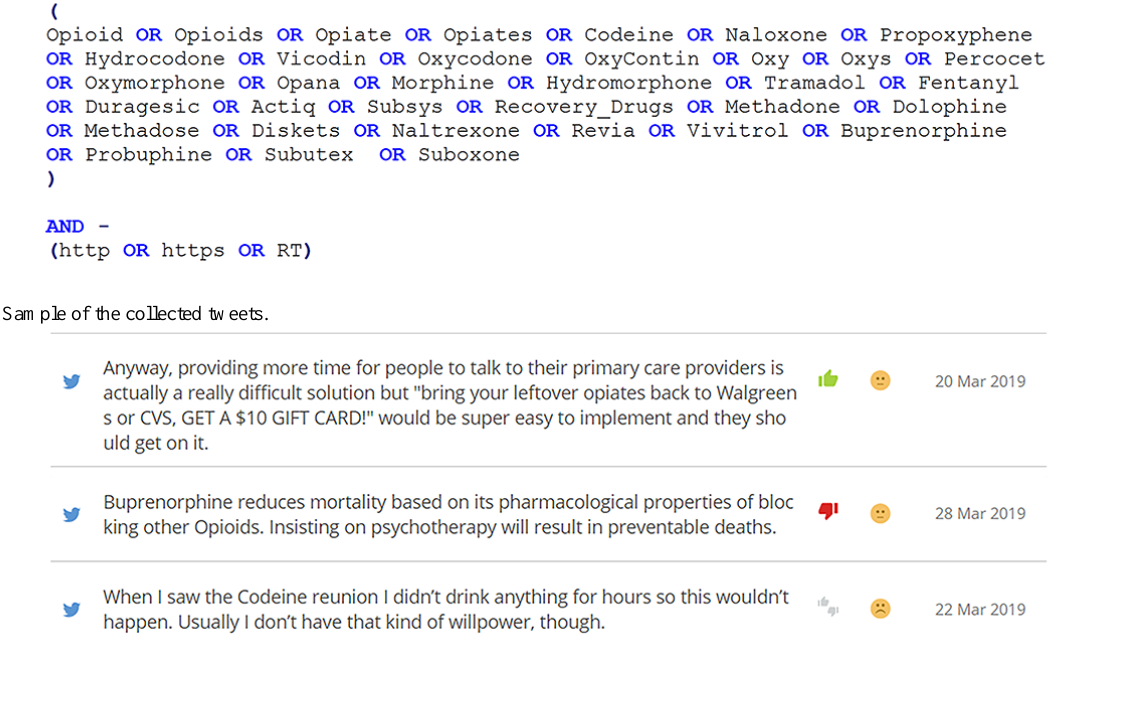
Figure 6. A search query based on the terms and concepts from the opioid drug abuse ontology to collect opioid-related users’posts.